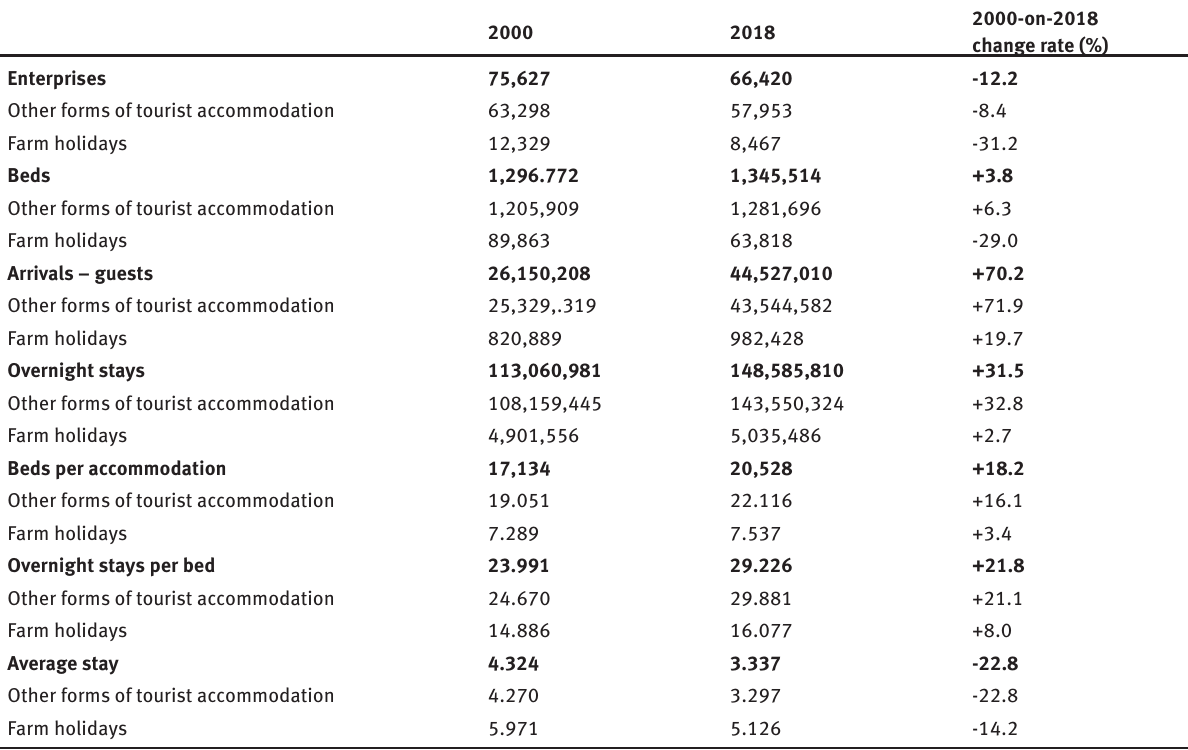
Table 1: Select tourism key figures 2000 and 2018 (Statistics Austria